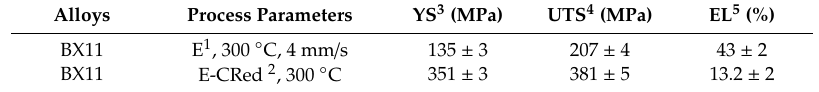
Table 1. Tensile properties of E-CRed BX11 compared with the as-extruded sample. Alloys Process Parameters YS 3